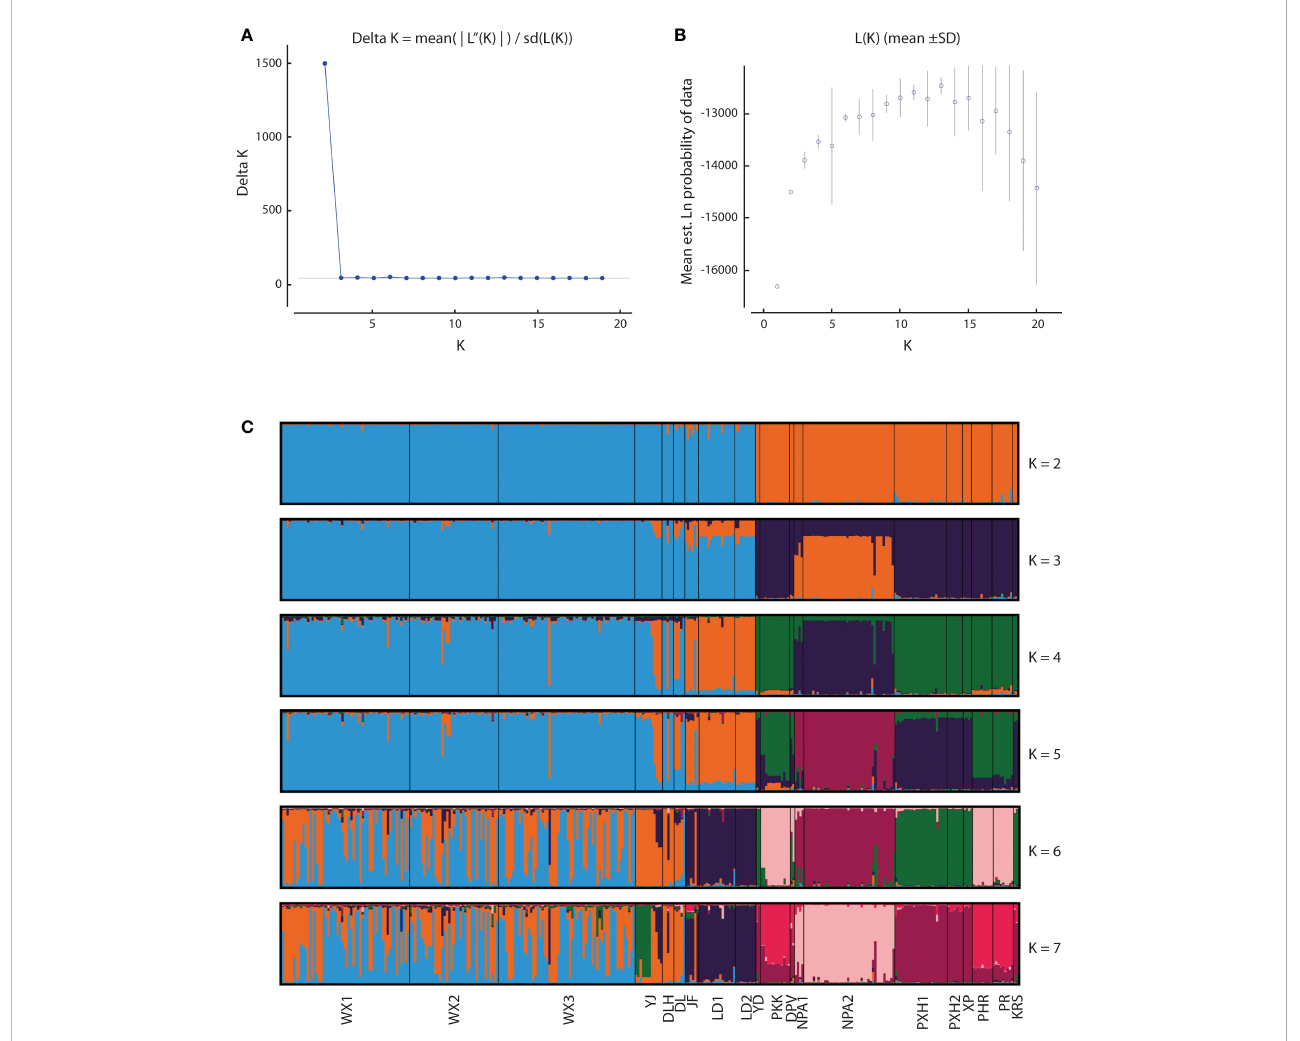
FIGURE 2 Bayesian estimates of genetic structure in the 20 Phalaenopsis pulcherrima populations using STRUCTURE. (A) Delta K values identi fi ed using STRUCTURE HARVESTER, revealing a peak in Delta K at K = 2. (B) Mean likelihood L(K) values (± SD) identi fi ed using STRUCTURE. (C) Plots of posterior probabilities for 323 individuals assigned to K genetic clusters based on admixture analysis for K = 2 to 7. Different colour bars indicate assignment to different K genetic clusters. Populations are delimited by black lines, with the corresponding population code shown at the bottom.